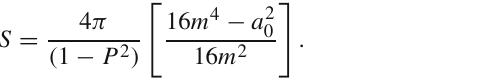
In the equation above, χ μ = ( 1 , 0 , 0 , 0 ) consists in a